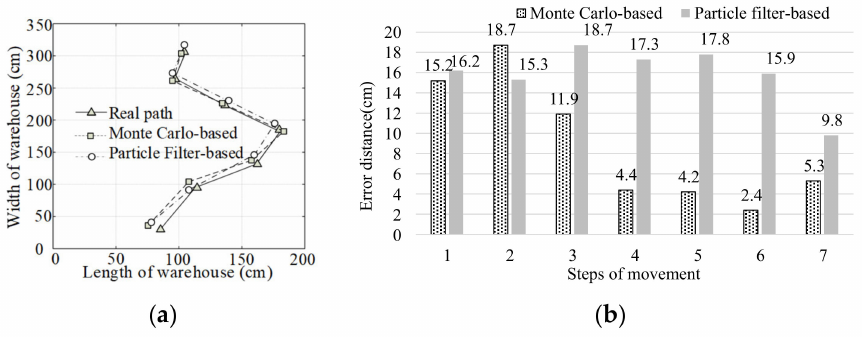
Figure 12. Experiment positioning results ( a ) and positioning errors ( b ) when the particle filter-based algorithm uses one large footprint of a radius of 128